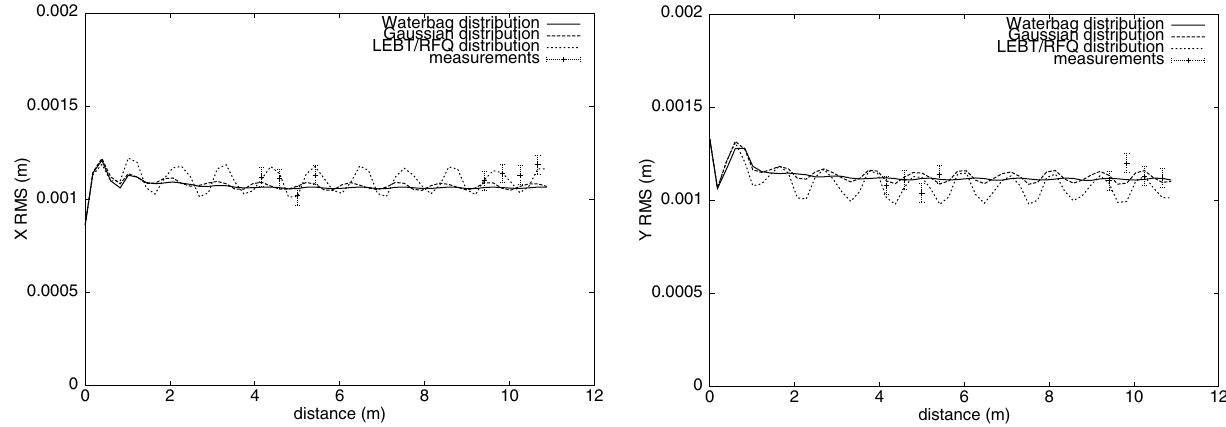
FIG. 3. X and y rms size at the center of the drift space as a function of distance at 75